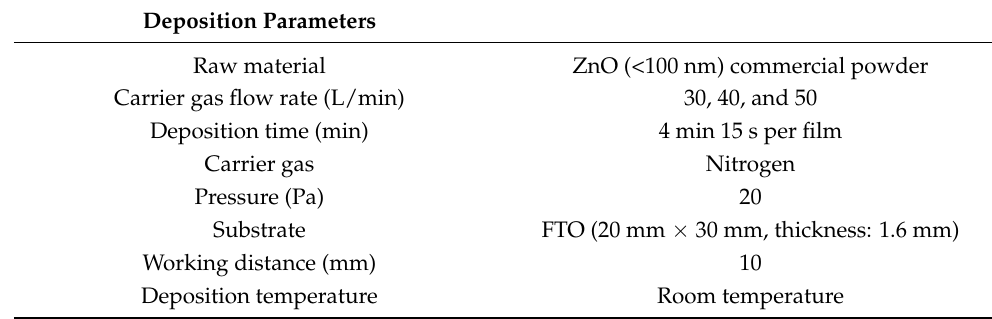
Table 1. Deposition parameters of the ZnO films using the AD